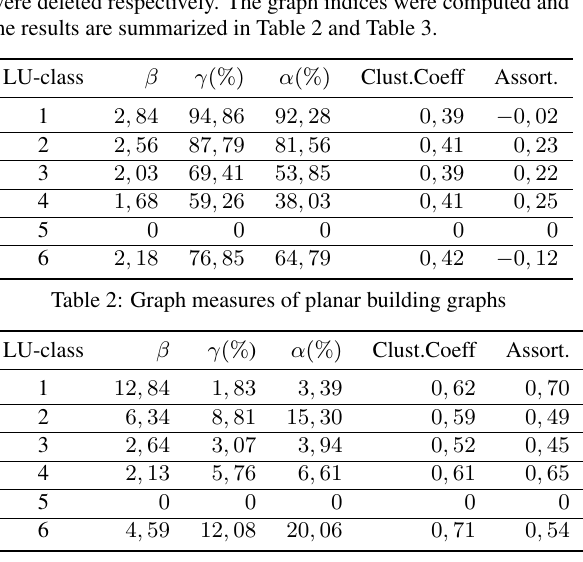
Table 3: Graph measures of non-planar building